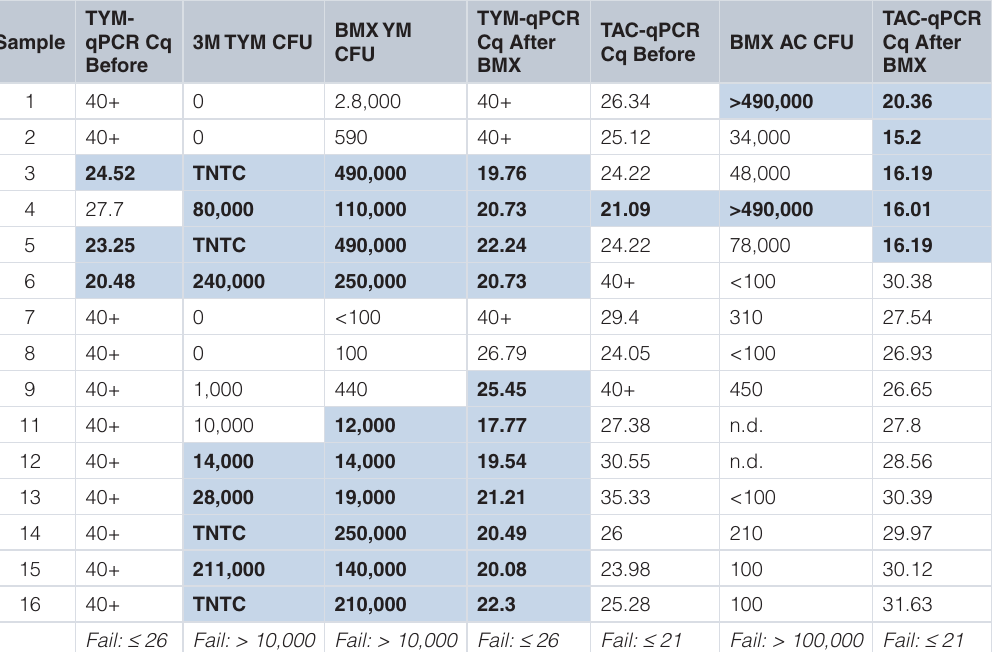
Table 1. Quantitative PCR and colony count results. Column 1: sample number; Column 2: results TYM-qPCR signals in terms of quantification cycle (Cq); Column 3: colony counts for 3M TYM plates; Column 4, inferred colony counts from BMX YM cards, Column 5: TYM-qPCR Cq signals after culture in the BMX YM system; Column 6: TAC-qPCR Cq signals from extracted plant material; Column 7: inferred colony counts from BMX AC cards, and Column 8: TAC-qPCR Cq signals after culture in BMX YM cards. Results in bold type and shaded boxes indicate failed tests. Abbreviations: BMX: Biomerieux, TYM: total yeast and mold, YM: yeast and mold, TNTC: too many to count, TAC: total aerobic count, AC: aerobic count, n.d.: not done. The AC and TYM failure thresholds for colony counts on the 3M and Biomerieux platforms are 100,000 CFU/g and 10,000 CFU/g respectively. The TAC and TYM qPCR failure thresholds are Cq ≤ 21 and Cq ≤ 26,